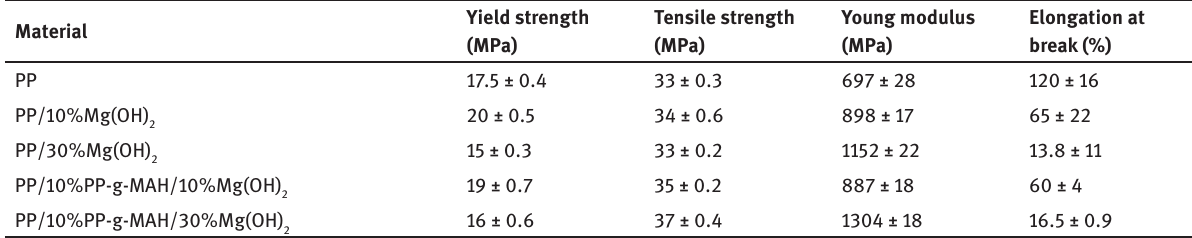
and contained PP-g-MAH. 2